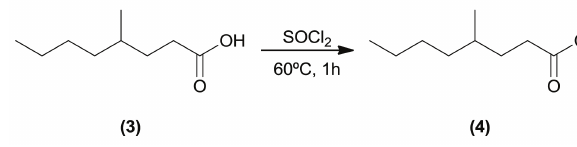
Figure 2: Step 2 of the synthesis procedure of (±)-DMBO. Preparation of (±)-4-methyloctanoyl chloride ( 4 ) from (±)-4-methyloctanoic acid ( 3 ).